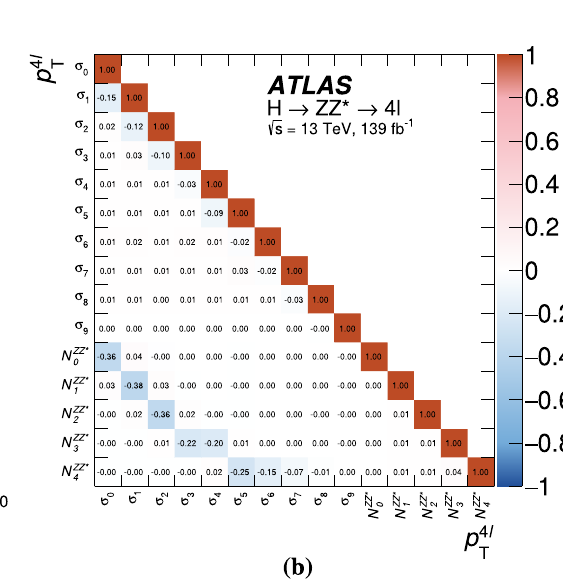
Fig. 19 a Differential fiducial cross section for the transverse momen- tum p 4 (cid:3) of the Higgs boson, along with b the corresponding correlation T matrix between the measured cross sections and the Z Z ∗ background normalisation factors. The measured cross sections are compared with ggF predictions by MadGraph5_aMC@NLO -FxFx, NNLOJET , RadISH , and NNLOPS , where MadGraph5_aMC@NLO -FxFx and NNLOPS are normalised to the N 3 LO total cross section with the listed K -factors while the normalisations for NNLOJET and RadISH are to their respective predicted cross sections. MC-based predictions for all other Higgs boson production modes X H are normalised to the SM predictions. The error bars on the data points show the total uncer- tainties, while the systematic uncertainties are indicated by the boxes. The shaded bands on the expected cross sections indicate the PDF and